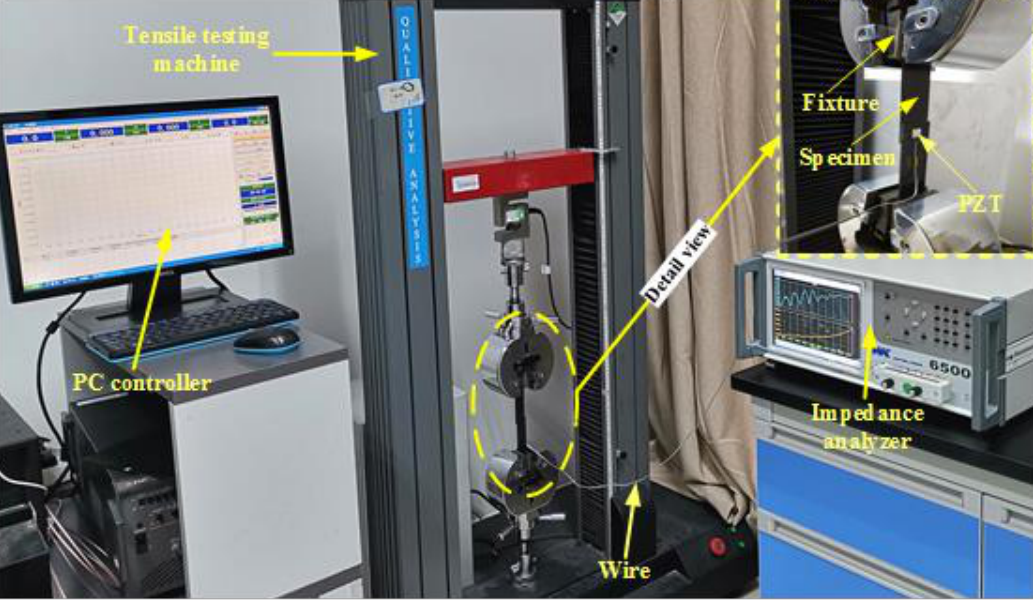
Figure 2. Testing platform for single-lap joint quasi-static behavior monitoring.